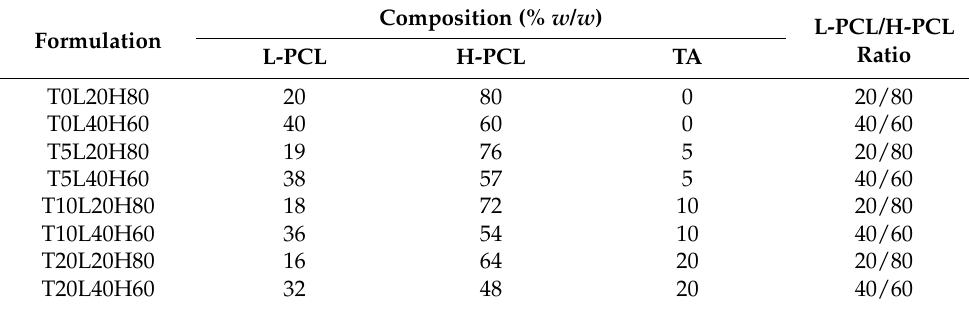
Composition (% w / w